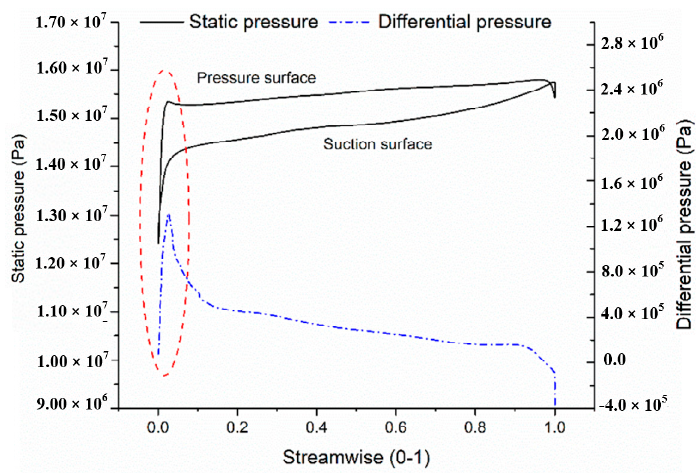
Appl. Sci. 2019 , 9 , x FOR PEER REVIEW Figure 5. Pressure distribution on both sides of the blade at span = 0.5. Figure 5. Pressure distribution on both sides of the blade at span = 0.5.